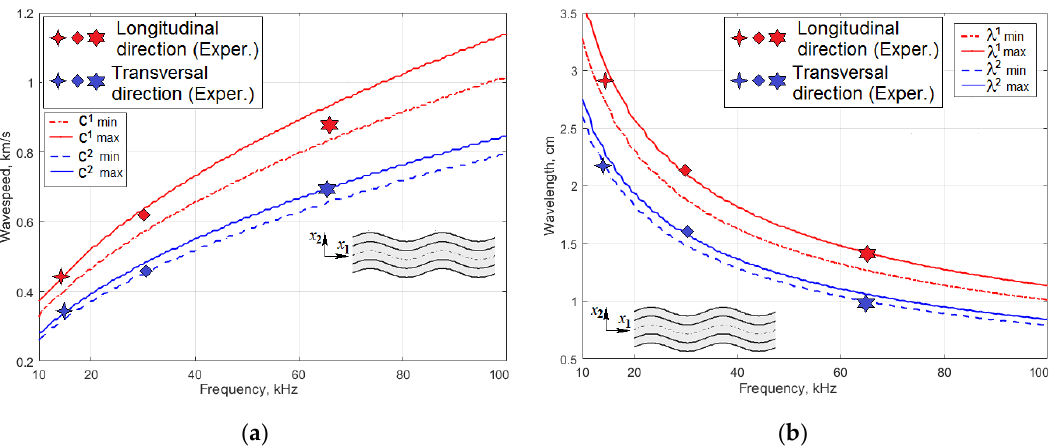
Figure 1. The dispersion curves for the wavespeeds ( a ) and wavelengths ( b ) of the anti-symmetric A0 Lamb waves propagating along ( 1 ) and across ( 2 ) the main axis of orthotropic symmetry.